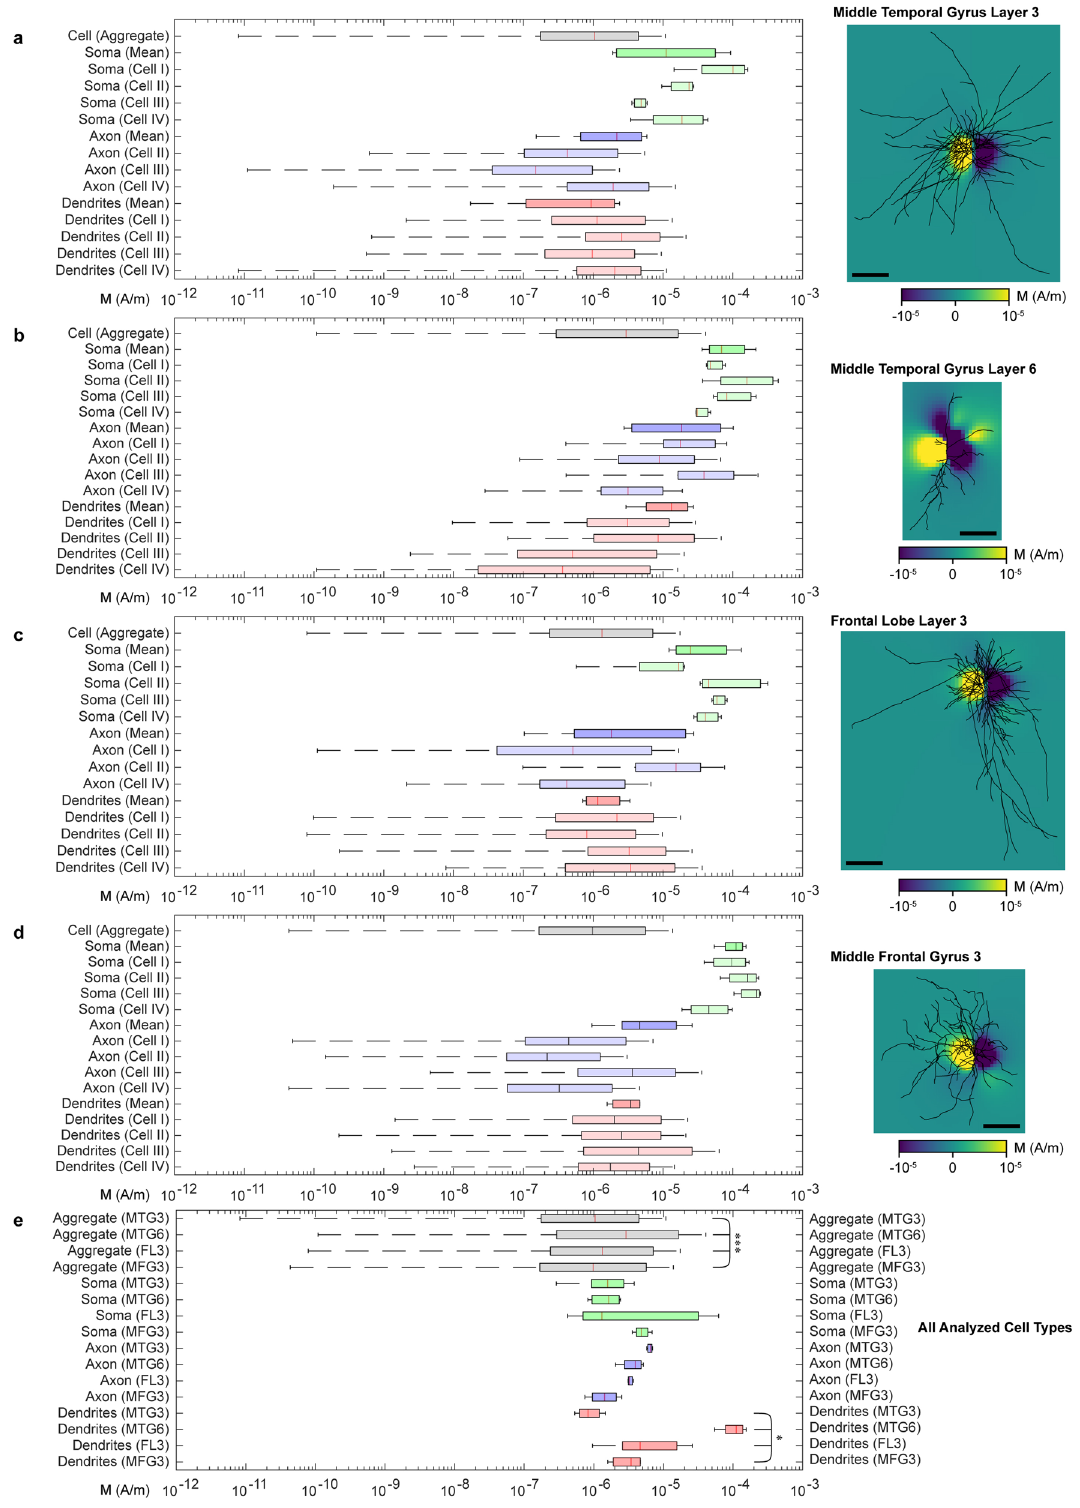
Figure 4. Distribution of magnetization from single spiking neurons. Shown above are magnetization maps of a spiking cortical layer 3 middle temporal gyrus neuron ( a ), layer 6 middle temporal gyrus neuron ( b ), layer 3 frontal lobe neuron ( c ), and a layer 3 middle frontal gyrus neuron ( d ). Shown in right panels in ( a )–( d ) are magnetization magnitude and sign for a bias field in the x direction. The slices are taken from the x–z plane. The left panels show the absolute value magnetization mean (red line), 1st and 3rd quartiles (colored boxes), and outliers (Q1 -1.5*IQR; Q3 + 1.5*IQR) for all regions of all cells, as well as for total aggregated data, on logarithmic scale. Scale bar = 200 µm for ( a – d ). ( e ) Salient bar and whisker entries from cell types in panels a, b, c, and d. Note the statistical significance (*p < 0.05, ***p < 0.001, one-way ANOVA) between dendritic compartments and total cell aggregate